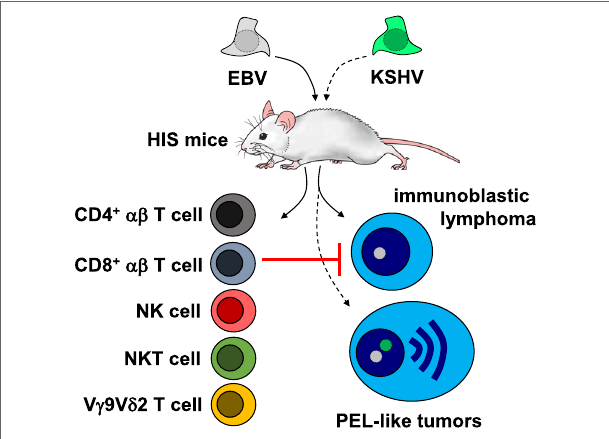
FiGURe 1 | Tumorigenesis and immune control of Epstein–Barr virus (EBV) with and without Kaposi sarcoma-associated herpesvirus (KSHV) co-infection in mice with human immune system components (HIS mice). KSHV co-infection converts EBV-induced immunoblastic lymphoma into primary effusion lymphoma (PEL)-like tumors. EBV-associated immunoblastic lymphomas are restricted by cytotoxic lymphocytes in humanized mice, including CD4 + and CD8 + T cells, natural killer (NK) cells, NKT cells, and V γ 9V δ 2 T